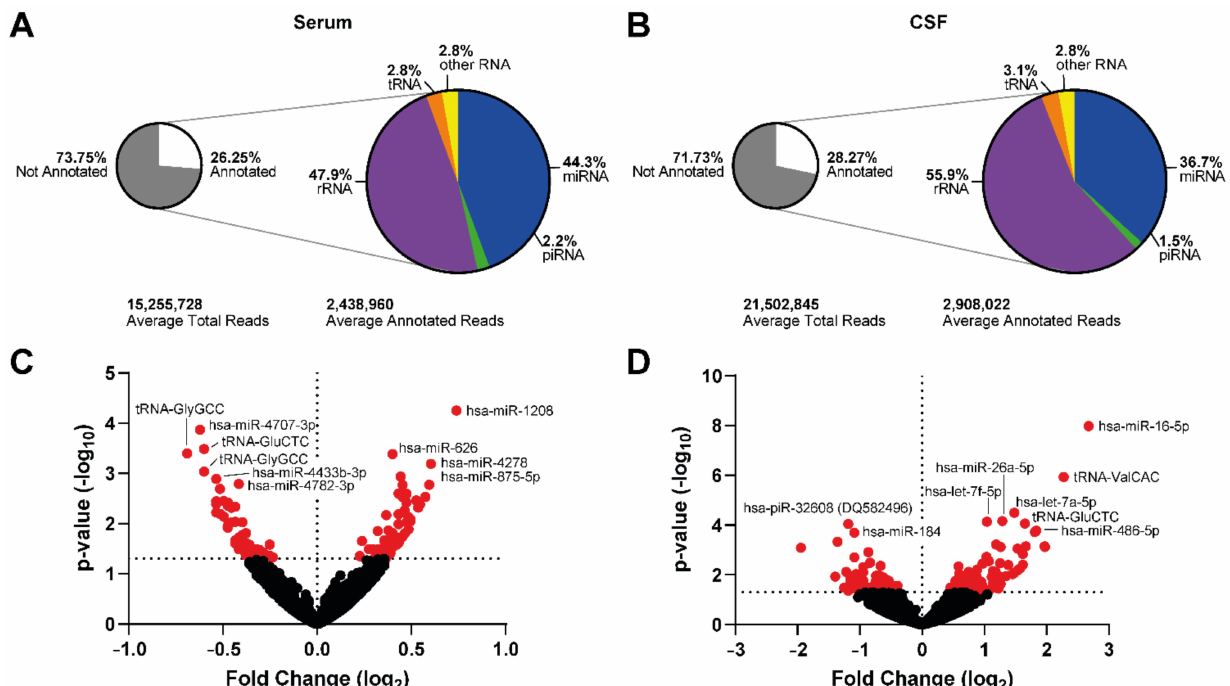
Figure 1. RNA-seq shows ncRNA may be dysregulated in the serum and CSF from PSP patients compared to healthy controls. Summary of the number of aligned reads that were annotated and the ncRNA species they aligned to in serum ( A ) and CSF ( B ) with volcano plots of ncRNA dysregulated in serum ( C ) and CSF ( D ). Dots in red were significantly dysregulated compared to healthy control, with the ten most significantly dysregulated